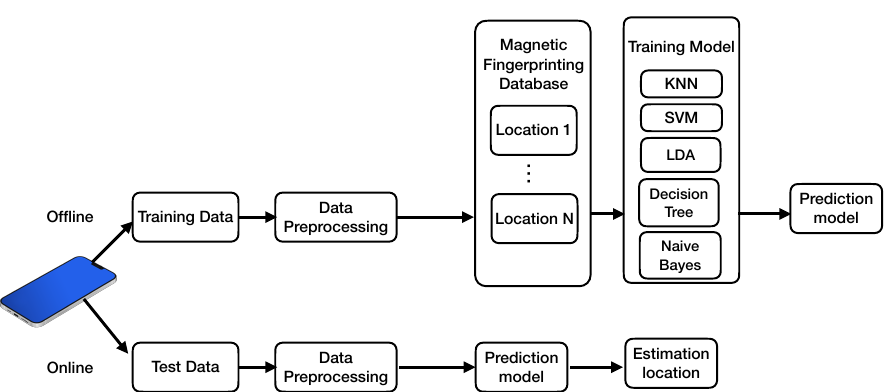
Figure 13. Architecture of magnetic-based positioning system.